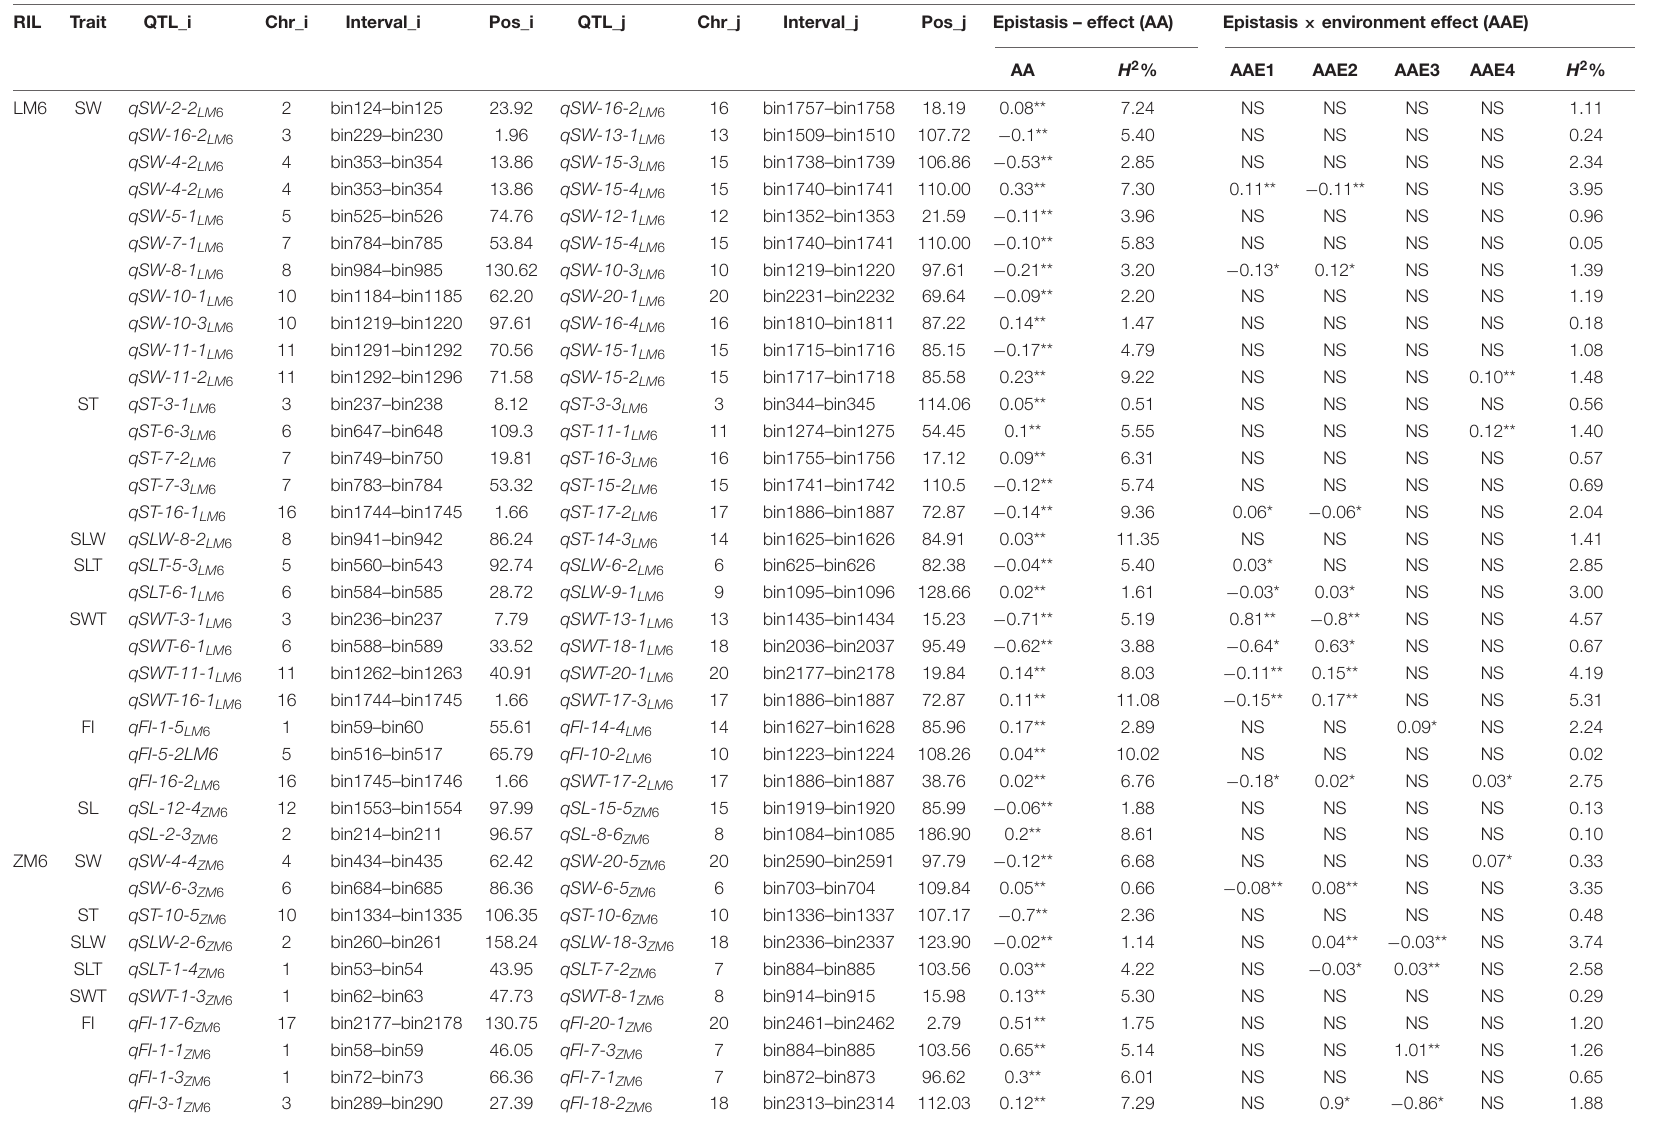
Chr_i and Chr_j indicate the two sites involved in epistatic interactions; Pos indicates genetic position for each of the sites. *p < 0.05; **p < 0.01; NS, non-significant. AA indicates epistatic effects between two QTLs; those with positive values showing two-locus genotypes being the same as those in parent Linhefenqingdou and Zhengyang (or Meng 8206) have the beneficial effects, while the two-locus recombinants take the negative effects. The case of negative values is the opposite. H 2 indicates phenotypic variation explained by epistatic effects. AE1, FY2012; AE2, JP2012; AE3, JP2014; and AE4,